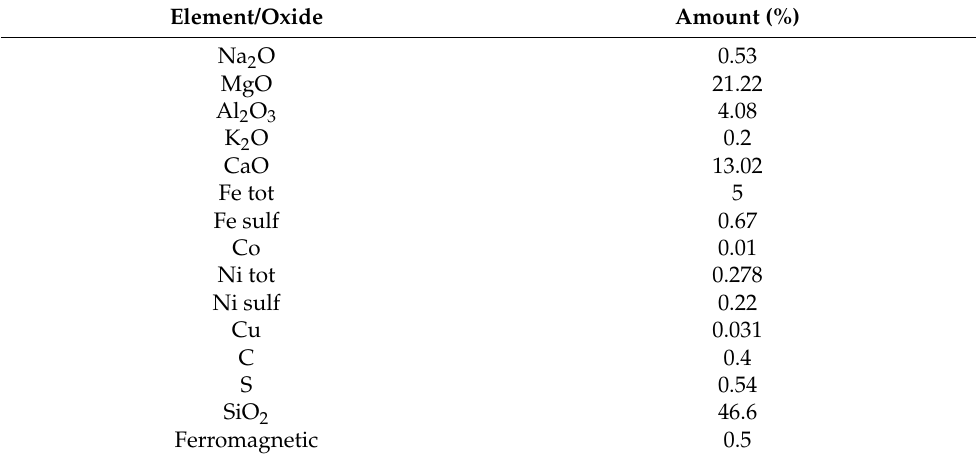
Table 5. Elemental composition of the solids removed from the thickener overflow